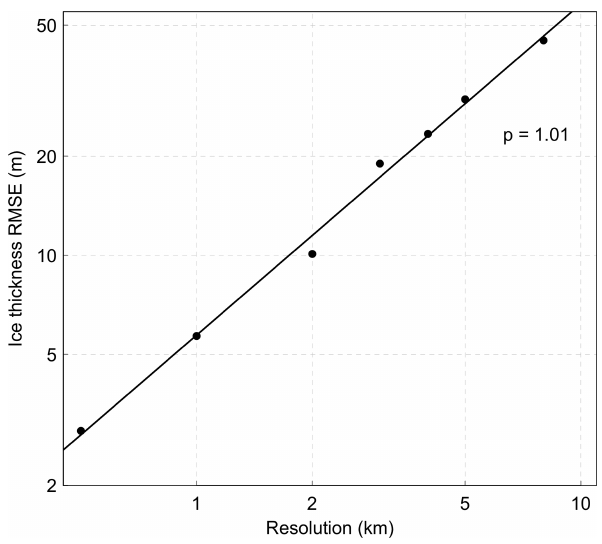
Figure 3. Root mean square error (RMSE) of the Halfar dome ex- periment after 200yr simulated by Yelmo compared to the analyt- ical solution versus model resolution. The value of p = 1 . 01 indi- cates the order of convergence as the resolution